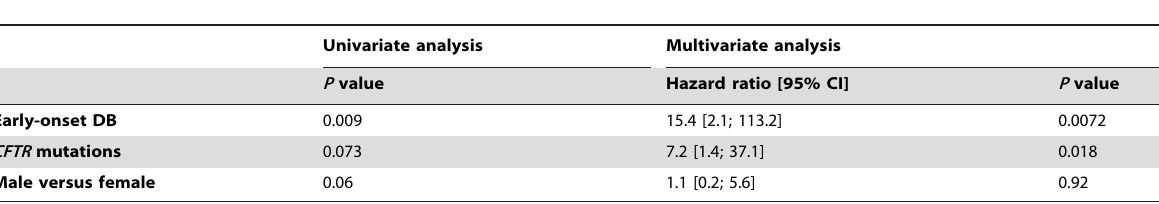
Table 2. Analysis of survival from birth of 30 patients with both RA and